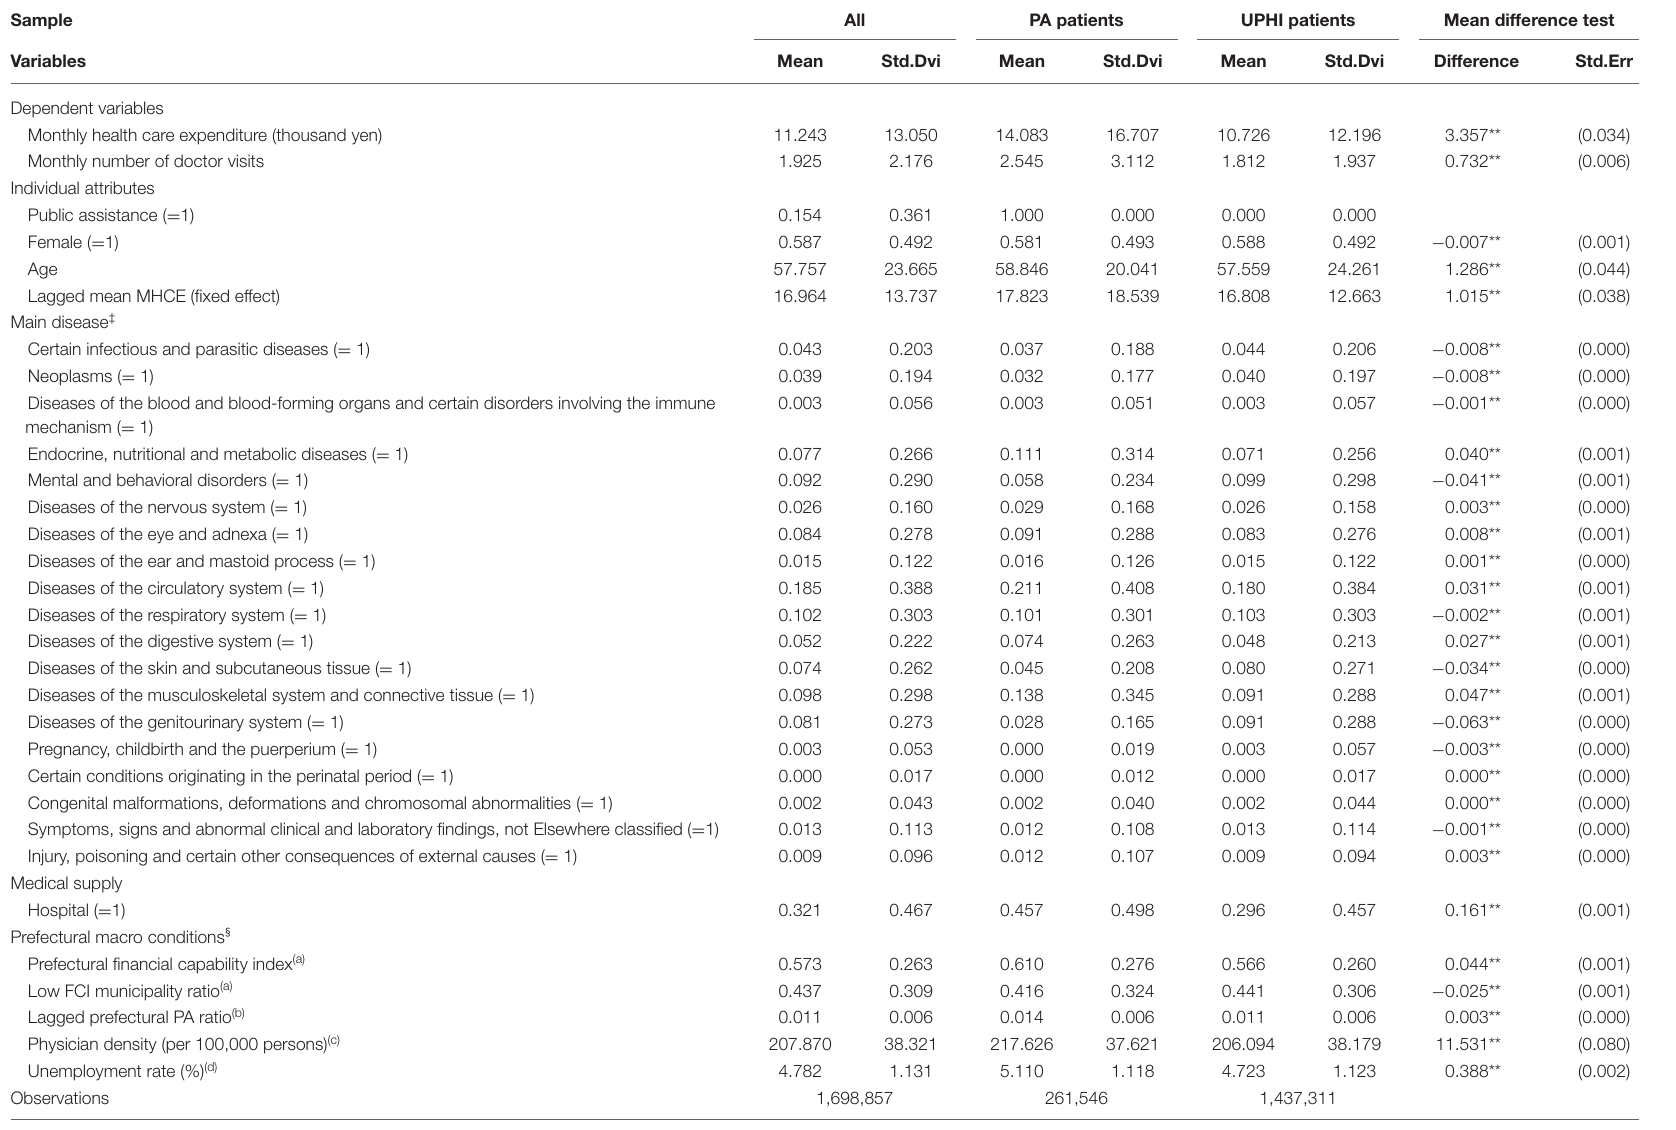
TABLE 2 | Descriptive statistics and mean comparison